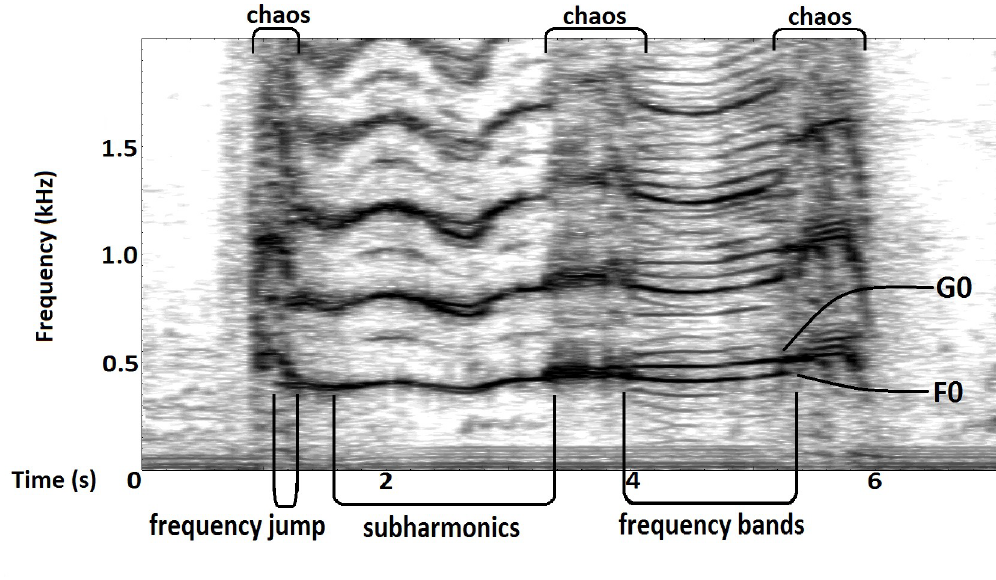
Fig 1. Spectrogram of a trumpet showing all different types of